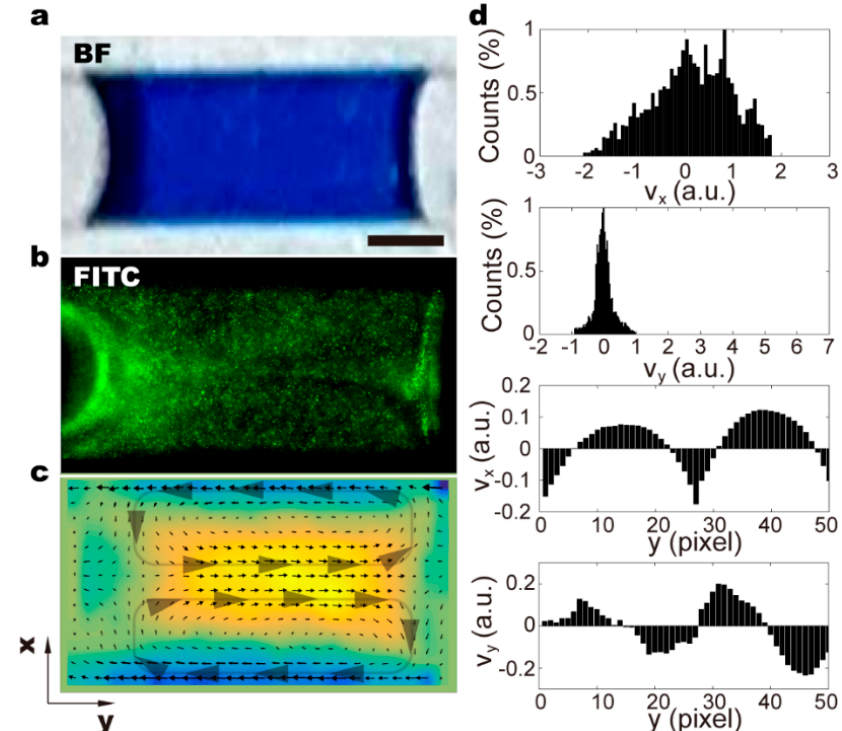
Figure 3. ( a – c ) 3D flow generated within the droplet in straight channels of the chip. It is demonstrated that circulating flow occurs within half of the droplet, and the mass transfer in the transversal direction still relies on molecular diffusion. ( d ) Distribution of flow rate within the moving droplet. The flow velocity is normalized to the driving flow rate to illustrate the mixing efficiency. We observe that flow distribution is symmetrical within a droplet, showing opposite flow profiles. The scale bar denotes 200 μ m.